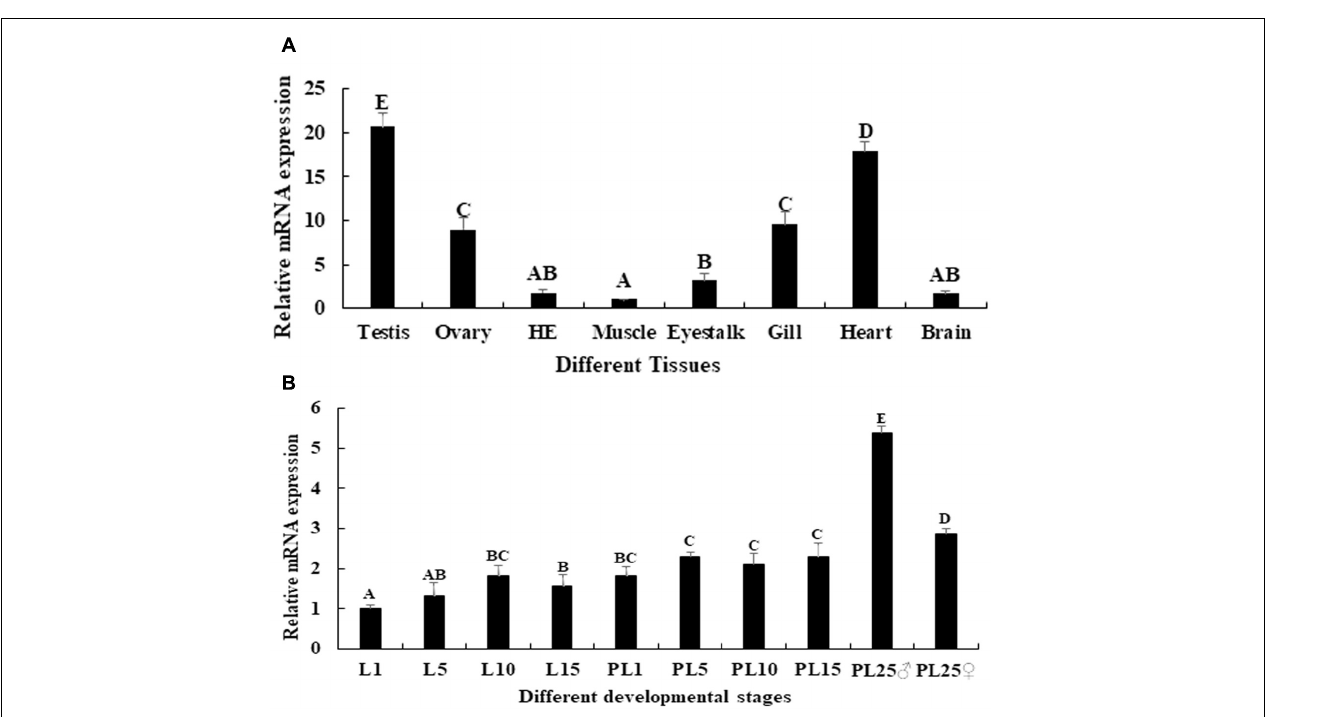
FIGURE 4 | Expression characterization of Mn-SDHB in different mature tissues and developmental stages. The amount of Mn-SDHB mRNA was normalized to the EIF transcript level. Data are shown as mean + SD (standard deviation) of tissues from three separate individuals. Capital letters indicate expression difference between different samples. (A) Expression characterization in different mature tissues. (B) Expression characterization in different developmental stages. HE,